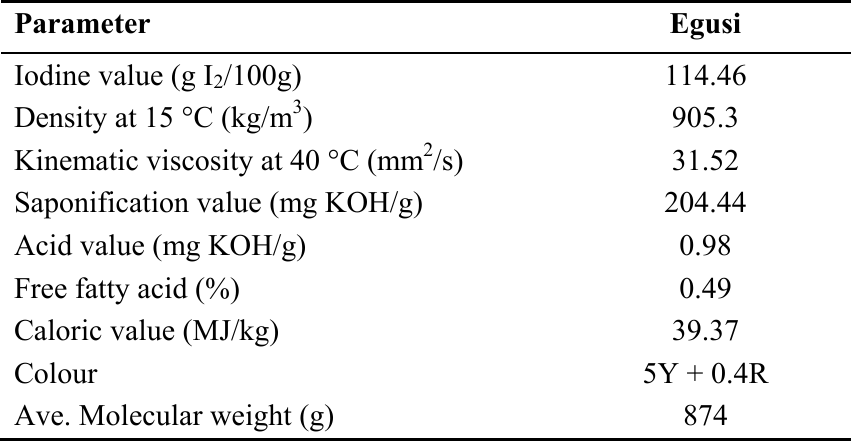
Table 1. Physicochemical properties of egusi melon seed